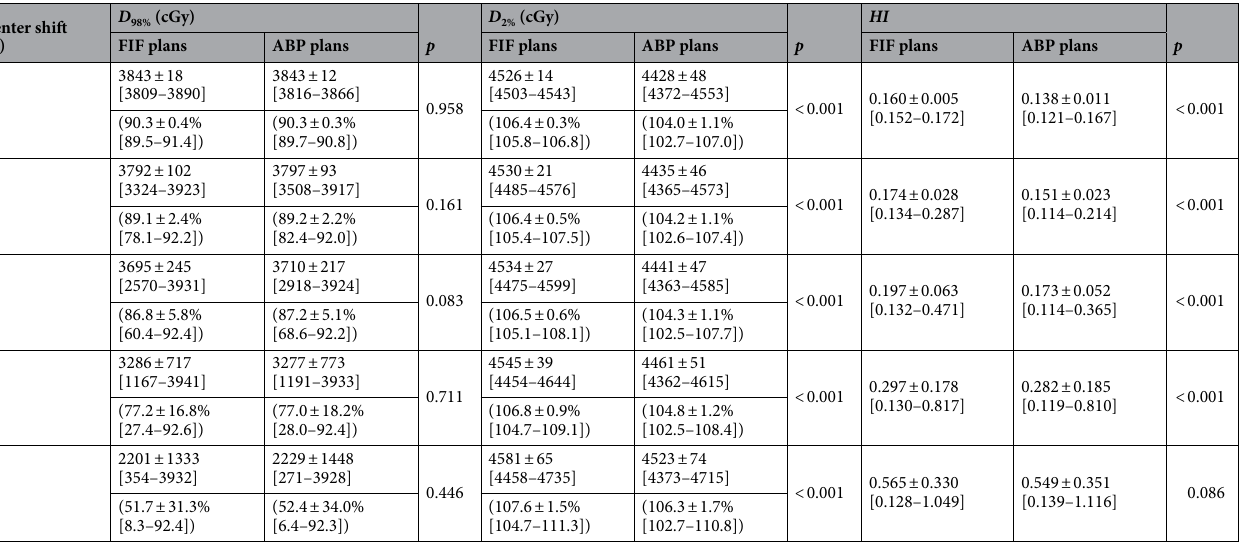
Table 1. Analysis of dose-volume data of 90% dose volume. D x % , absorbed dose received by x % of the volume; HI, homogeneity index; FIF, field-in-field technique; ABP, automated breast planning. The prescribed 90%